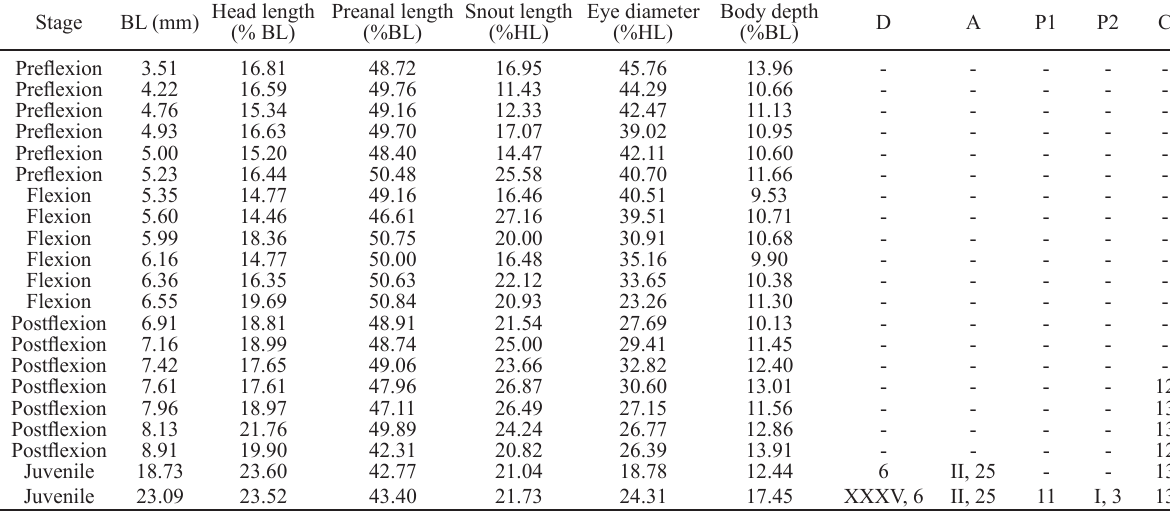
Table 1. – Morphometric data (%BL, % of body length; %HL, % of head length), and meristic counts (D, dorsal fin; A, anal fin; P1, pectoral fins; P2, pelvic fins; C, caudal fin) for larvae of Myxodes viridis .